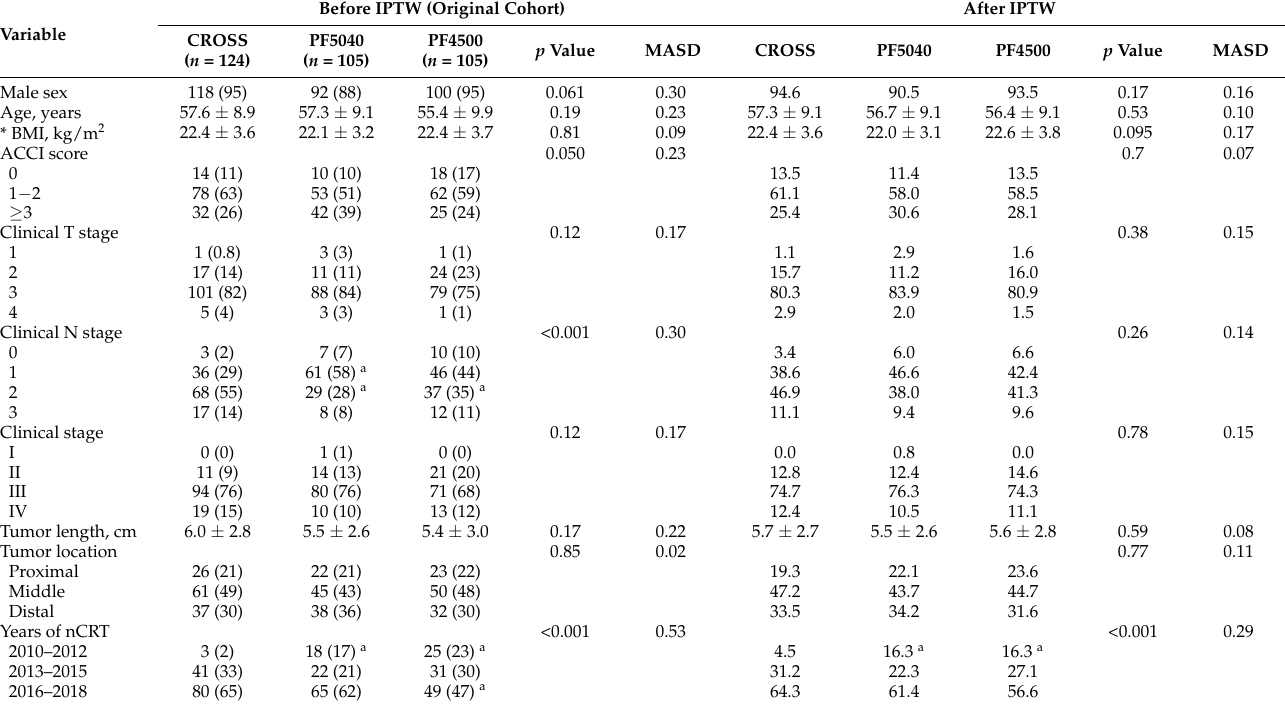
Table 1. Baseline characteristics of the three study groups before and after